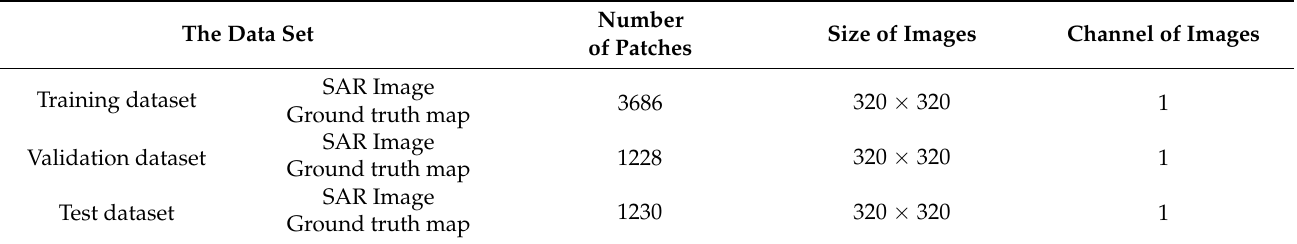
Figure 4. Data augmentation: ( a ) raw data; ( b ) horizontal flip; ( c ) vertical flip; ( d ) diagonal mirroring. Table 3. Training, validation, and test dataset.